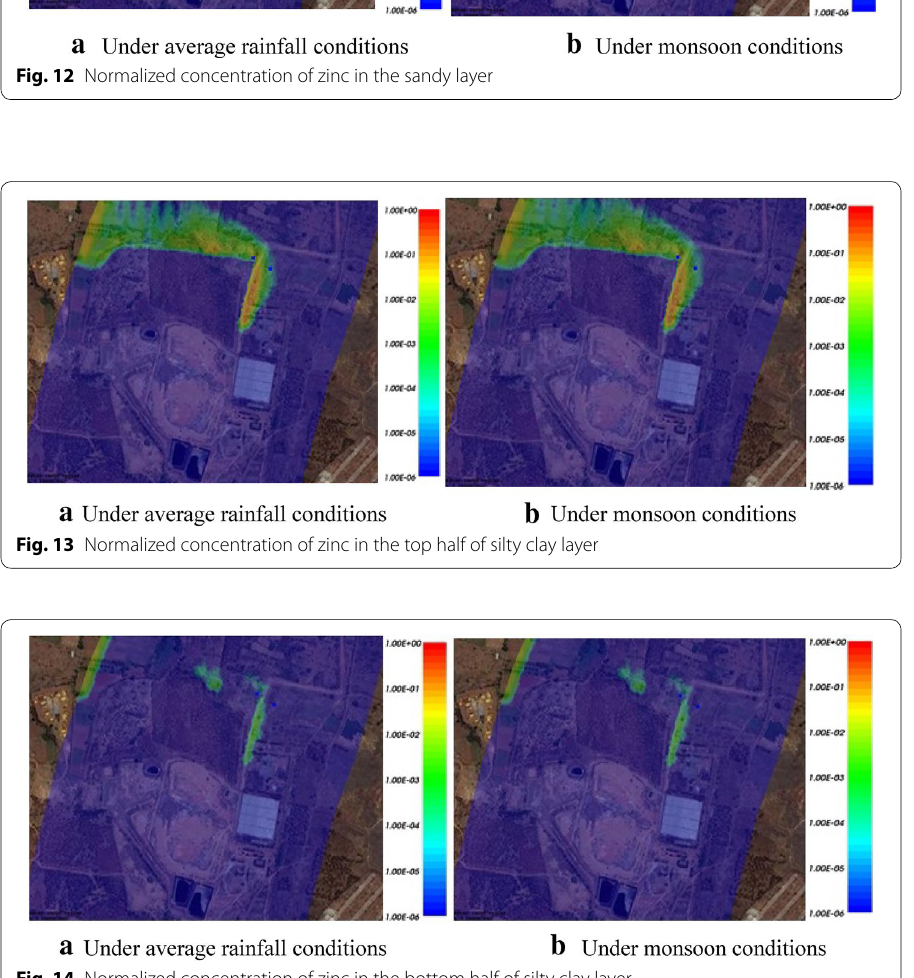
Fig. 14 Normalized concentration of zinc in the bottom half of silty clay